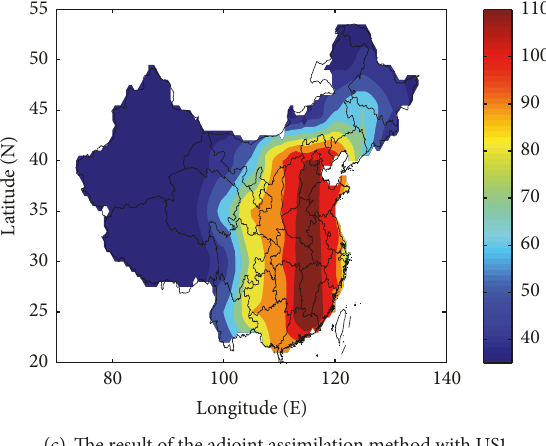
Figure 5: The 2D images of the results inverted by the adjoint assimilation method with different